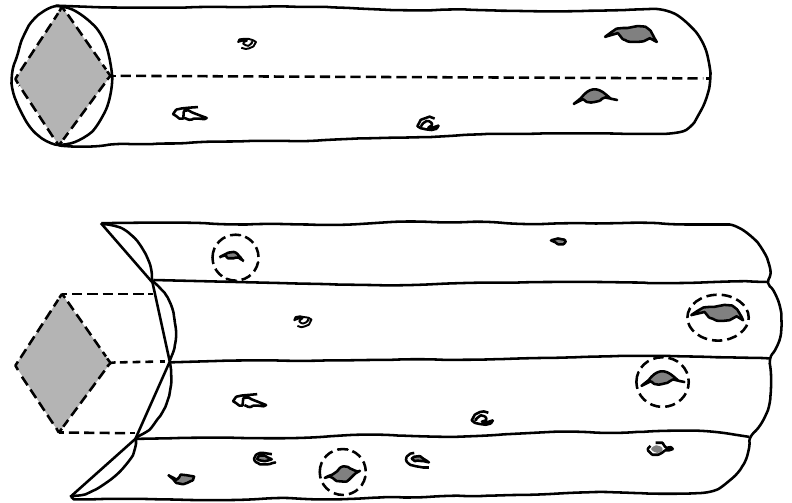
Figure 4. Method for calculating the largest limb average diameter (or branch index) for a log.